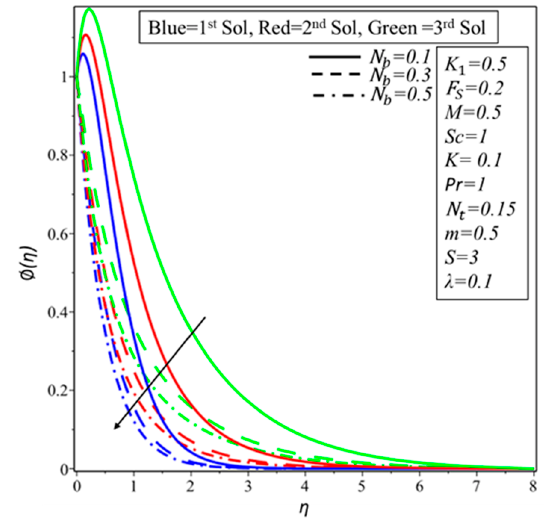
Figure 13. Nanoparticle concentration profiles for increasing values of N b .